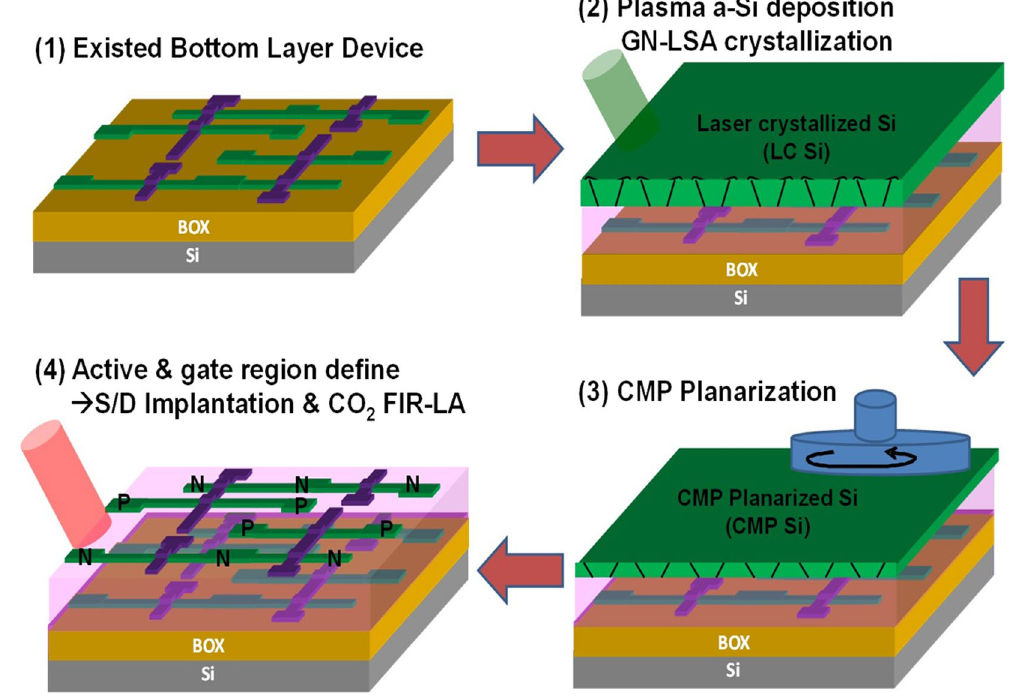
Figure 1. Schematics and process flows of low cost and low thermal budget monolithic 3D IC: (1) prefabrication of bottom layer devices, (2) deposition of an a-Si film followed by a laser crystallization process, (3) a chemistry mechanical publishing (CMP) process and (4) active/gate region via source/grain (S/D) implantation followed by activation of implants by a CO 2 laser annealing